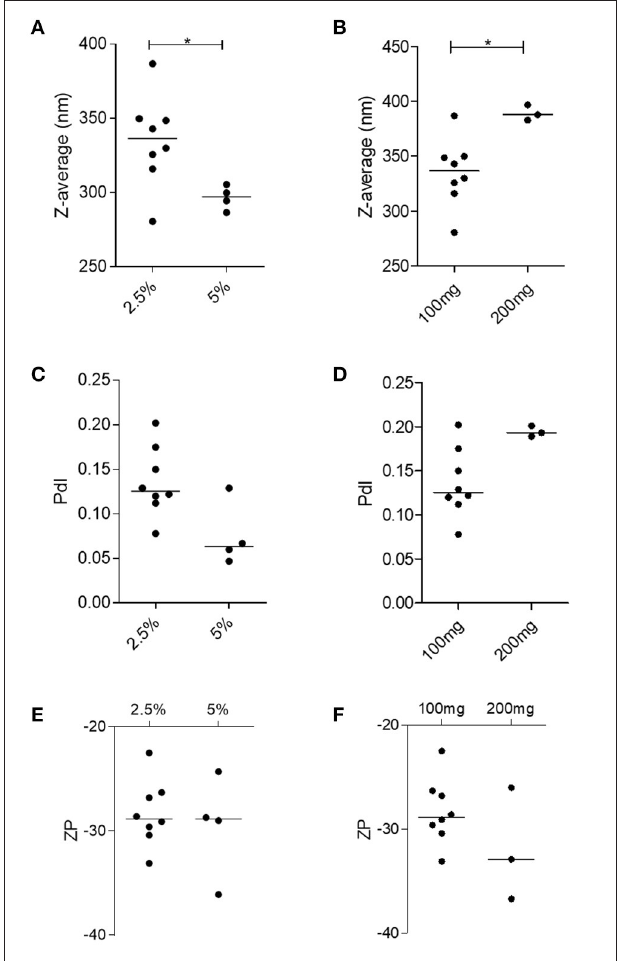
FIGURE 4 | Evaluation of the influence of amount of PLGA and PEG concentration on nanoparticle physiochemical features in NP2-17-DMAG. DLS evaluated the effect of varying amounts of PEG (A,C,E) and PLGA (B,D,F) on the size (A,B) , PdI (C,D) , and ZP (E,F) of NP2-17-DMAG. Each point represents an individual experiment. Mann-Whitney test, * p <